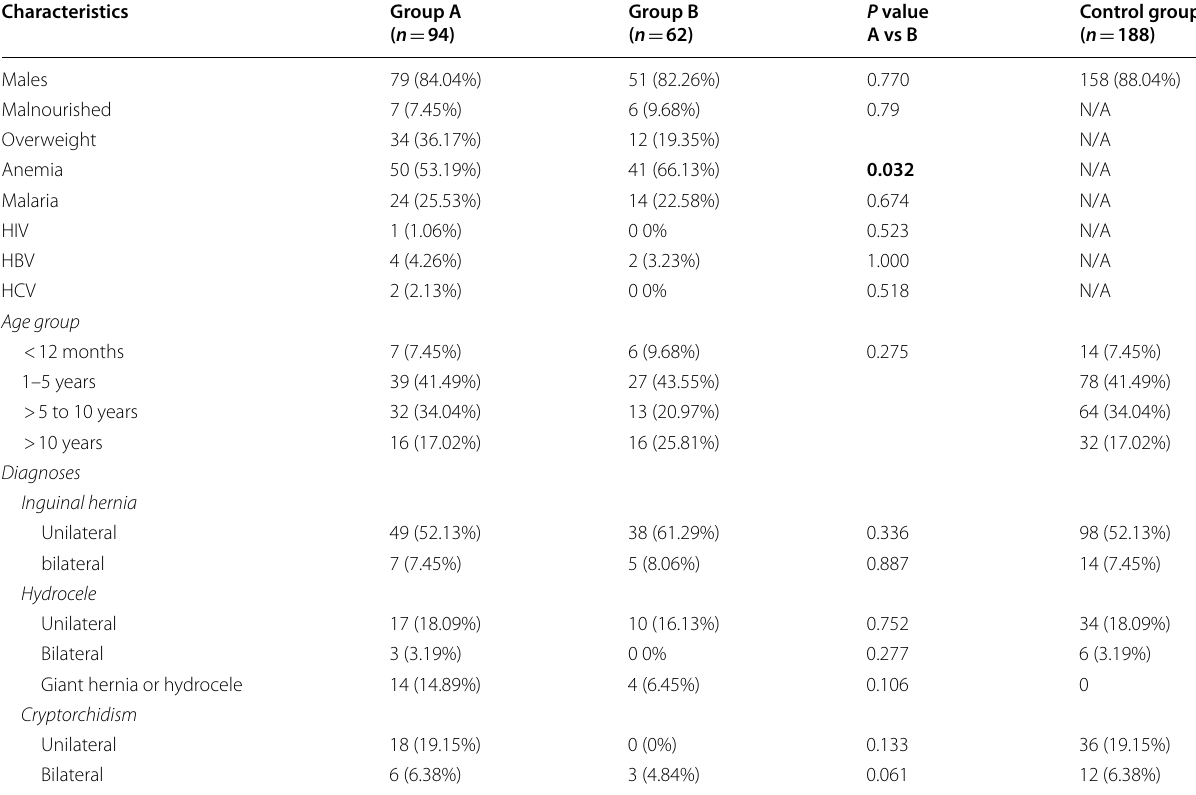
Table 1 Comparison of demographics between groups A and B